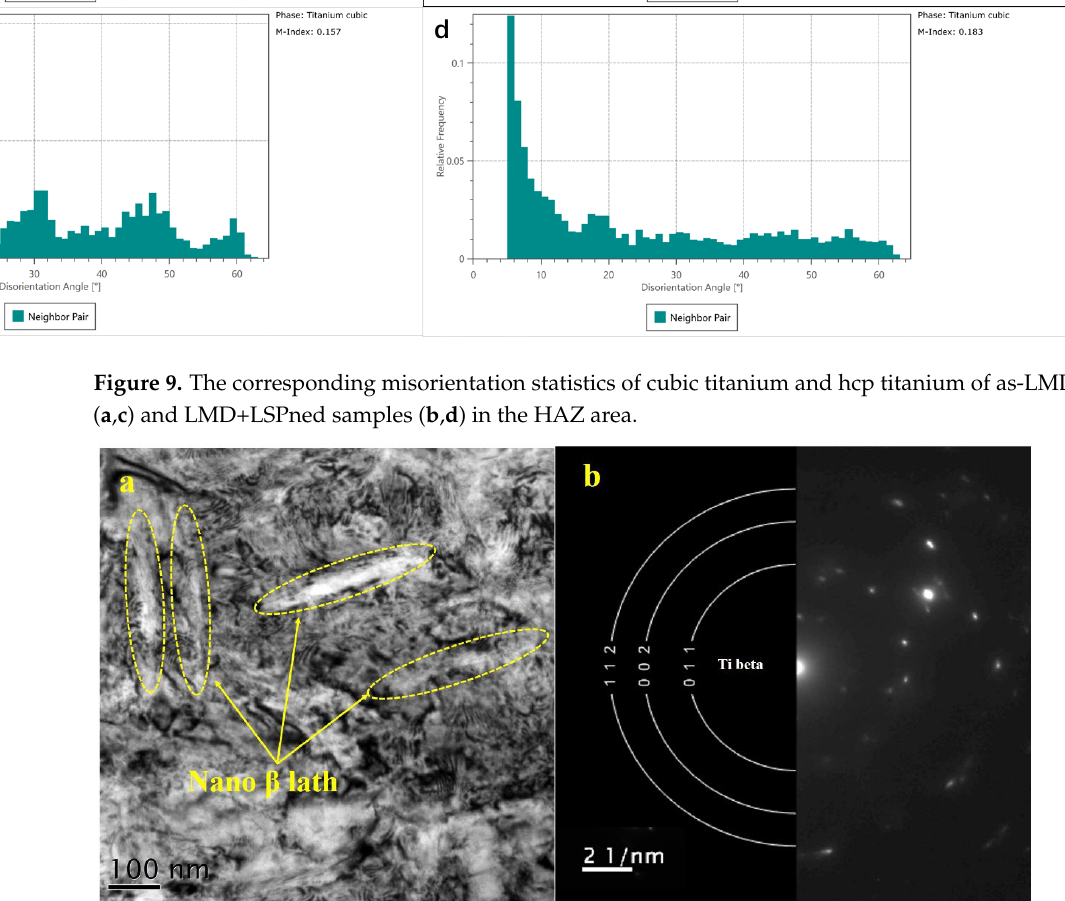
Figure 10. TEM image of the as-deposited area ( a ) and its corresponding SEAD image ( b ) of the LMD+LSPned sample.